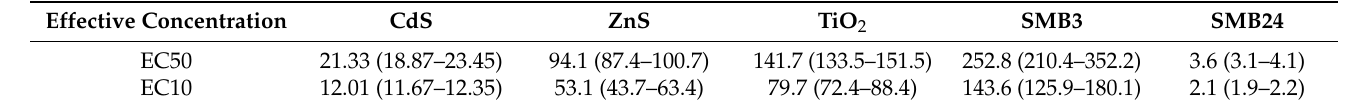
Table 1. The calculated EC10 and EC50 values of microalga growth inhibition (mg/L).